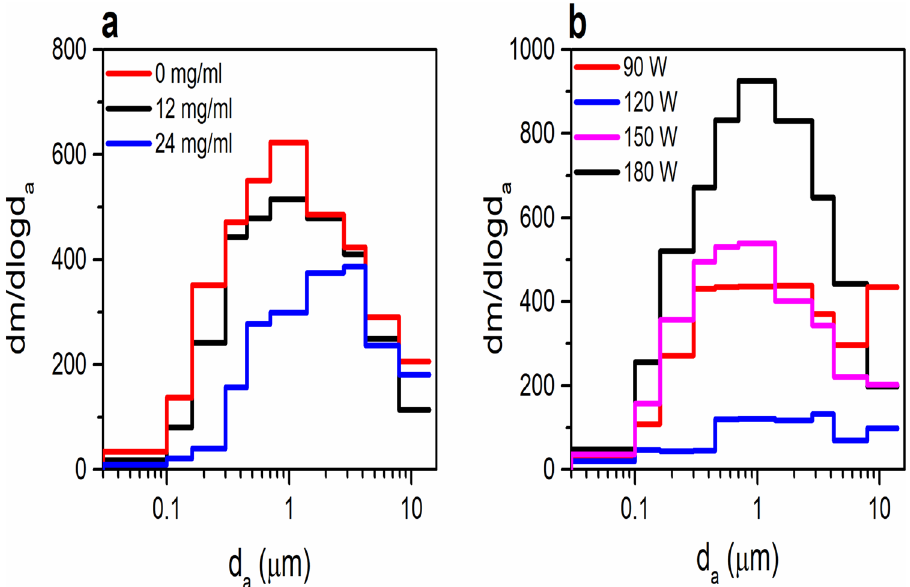
Figure 1. Normalized particle mass size distribution of e-vapors from ( a ) menthol flavored e-liquids of 0, 12, and 24 mg/ml nicotine concentrations (at 180 W) and ( b ) tobacco flavored e-liquids at 90, 120, 150 and 180 W (24 mg/ml nicotine content) using the 10-stage real time QCM cascade impactor. Experiments were carried out using a 2 s puff and 15 s wait time (n = 16). QCM Quartz crystal microbalance, mg/mL milligrams per milliliter, μm micrometer, W watts.